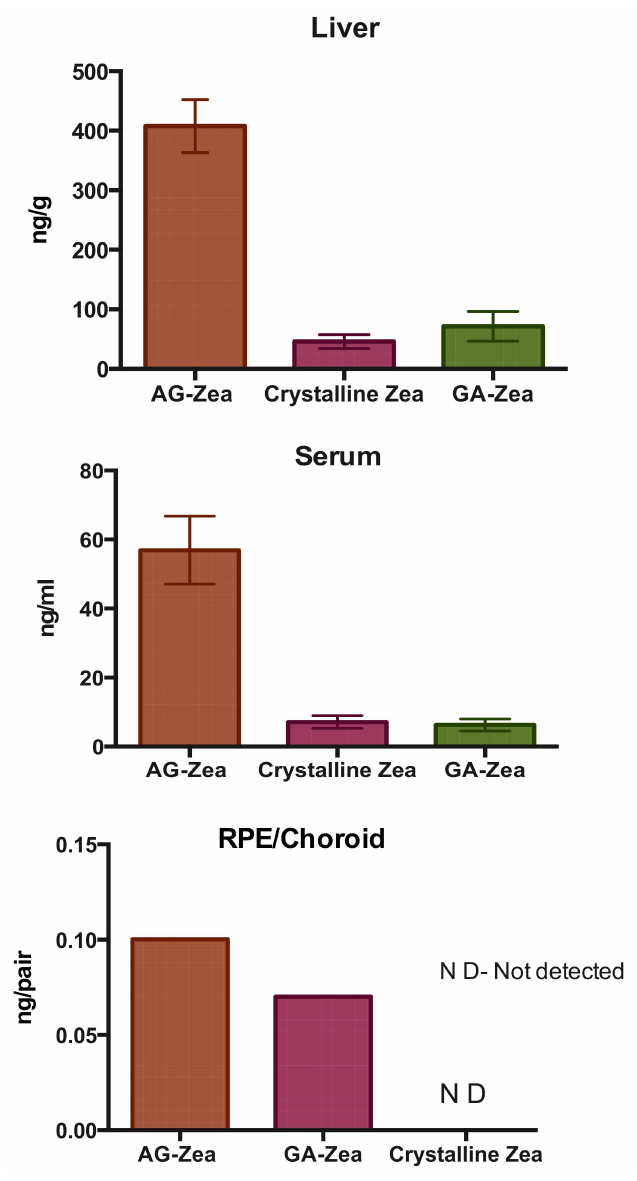
Figure 7. Comparison of three carotenoid delivery methods in C57BL / 6 wild type (WT) mice. 12-week-old WT mice were fed with chow containing zeaxanthin in the formulations of crystalline carotenoid, complex with glycyrrhizic acid (1:20) and complex with arabinogalactan (1:20). Values indicate means ± SD from 5 to 10 mice in each group. Retinal pigment epithelium (RPE) is the pigmented cell layer just outside the neurosensory retina that nourishes retinal visual cells, and is firmly attached to the underlying choroid and overlying retinal visual cells (adopted from